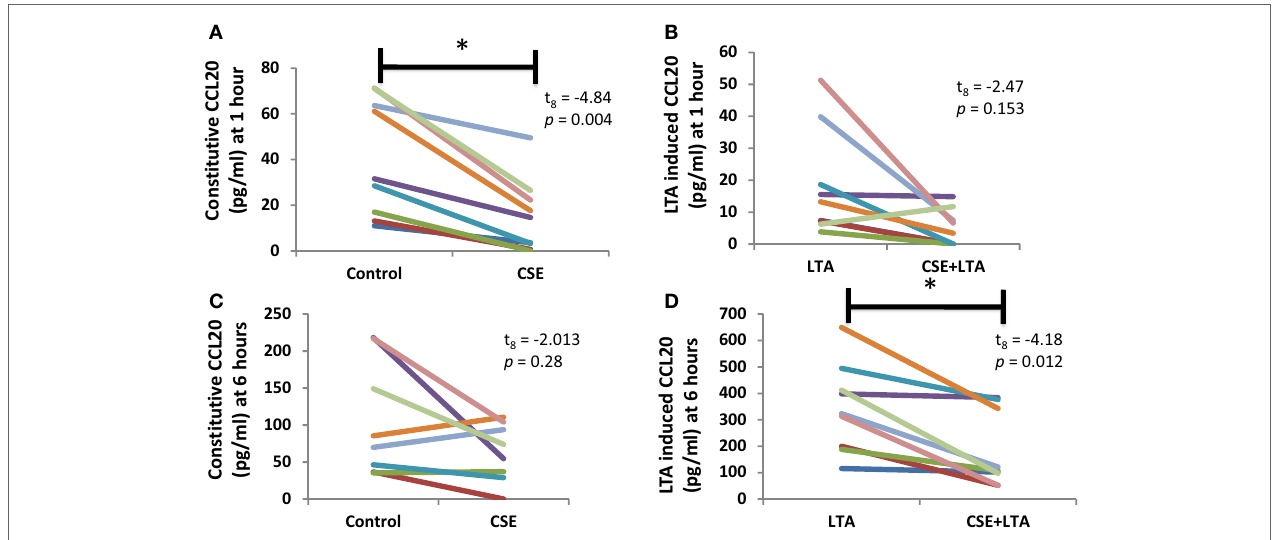
FigUre 5 | cse exposure significantly decreased constitutive apical ccl20 secretion at hour 1 (a) and lTa-stimulated apical ccl20 secretion at hour 6 (B). Apical CCL20 secretion from PHNECs from non-smoke-exposed individuals are shown at 1 h (a,B) and 6 h (c,D) post-LTA stimulation. Primary human nasal cell cultures were exposed apically to cigarette smoke extract in ALI media for 3 h, LTA and control treatments received ALI media only. CSE was then removed by suction and cells were rinsed twice with PBS. Subsequently, LTA and CSE + LTA treatments were stimulated apically with LTA from B. subtillis (10 μ g/ mL) in ALI media by applying 300 uL in the apical compartment. Supernatants were harvested at 1 and 6 h post-LTA stimulation. CCL20 was quantified by